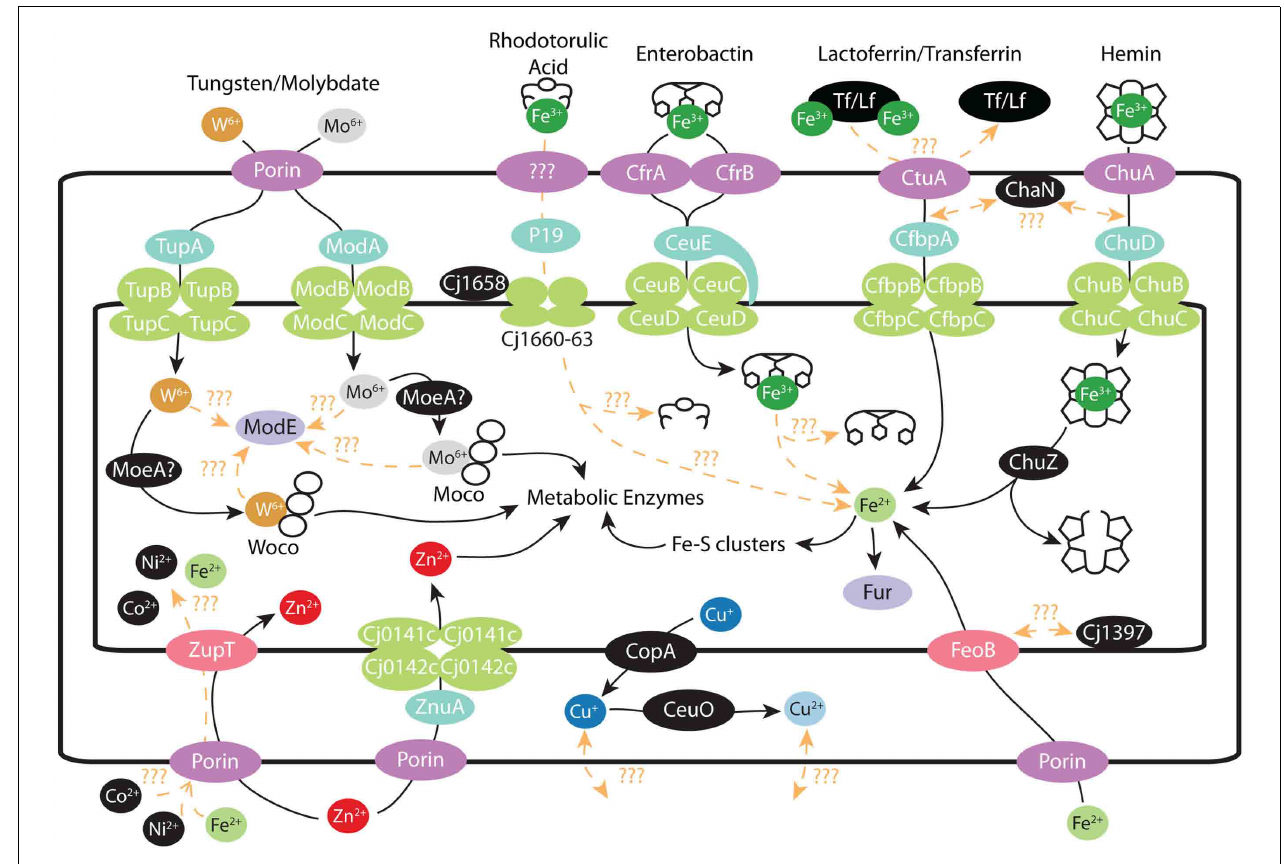
FIGURE 2 | Metal transport in C. jejuni : schematic of various metal transport systems present in C. jejuni . Where possible, proteins are colored by their function. Outer membrane proteins are denoted by dark purple, periplasmic proteins by turquoise, ABC transporters by green, periplasmic transporters by pink, and transcriptional regulators by light purple. Iron : ferric–rhodotorulic acid is imported into the periplasm though an unidentified outer membrane transporter and subsequent interactions with various proteins result in iron release and import into the